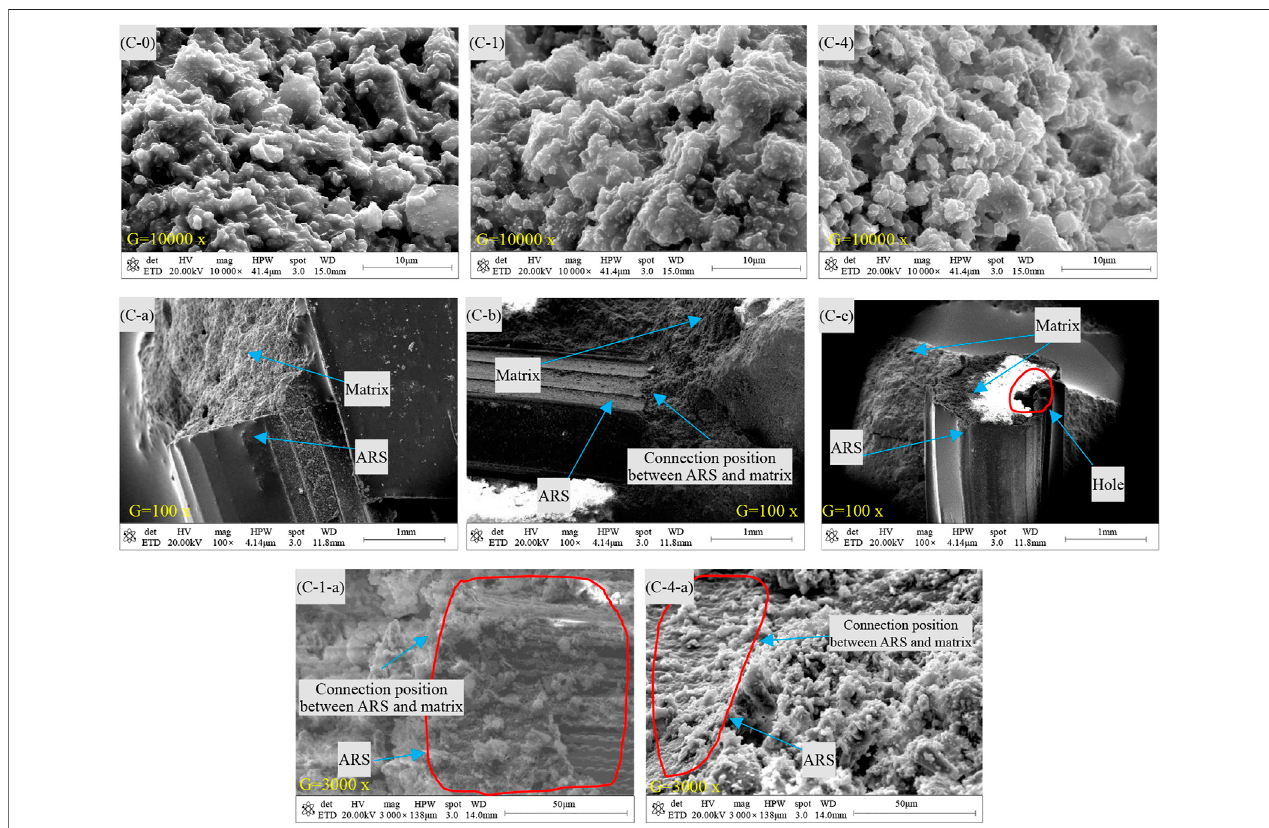
FIGURE 12 | SEM images of CTB and ARSCTB (G is the magni fi cation).